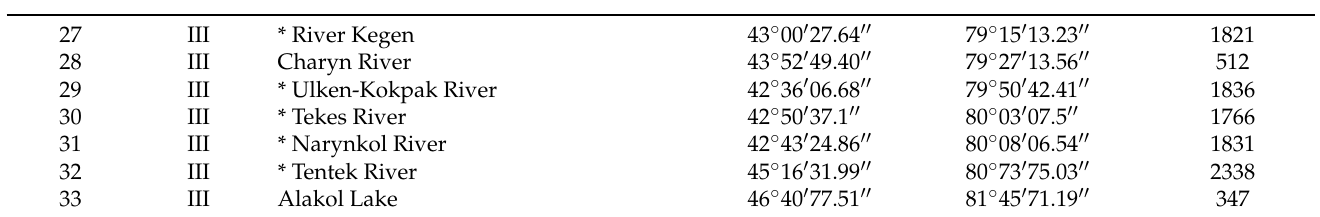
Figure 2a). Charophytes in Zhambyl region (II) were collected from seven sites, in three of which charophytes were found for the first time (Table 1, Figure 2b). Charophyte algae in the Ili River basin in Almaty region (III) of southeast Kazakhstan were collected from 21 sites, in 14 sites of which charophytes were found for the first time (Table 1, Figure 2c,d).